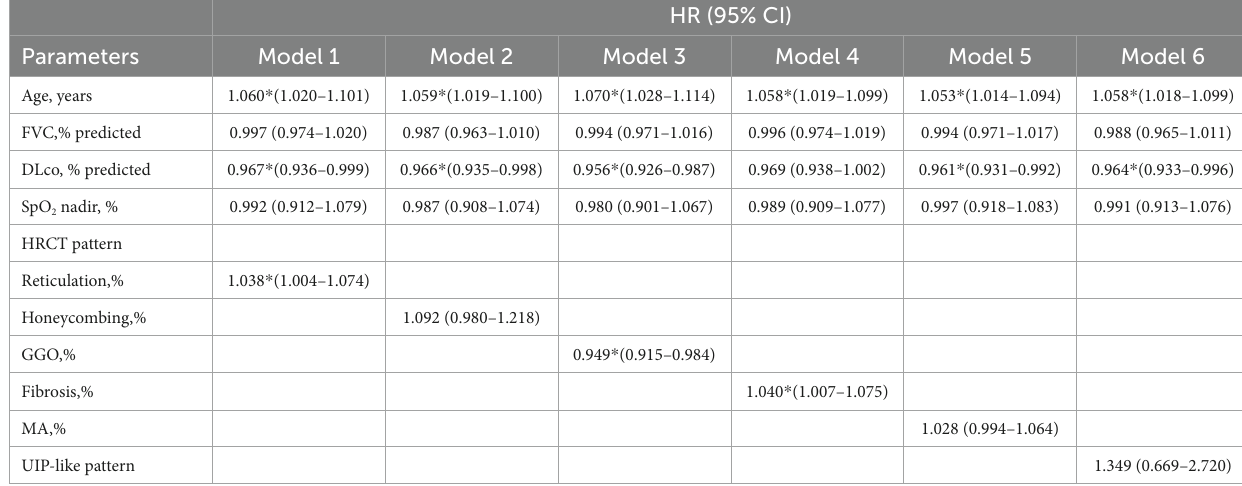
TABLE 4 Risk factor for mortality in patient with fibrotic HP using multivariable Cox proportional hazards model.